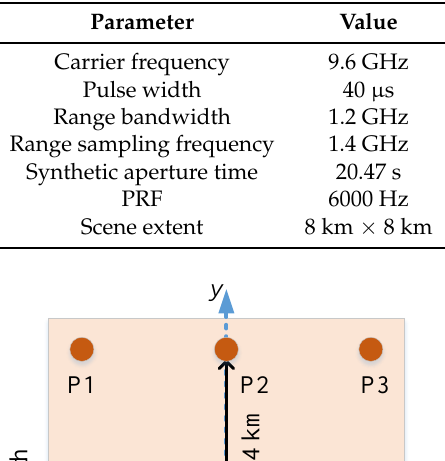
Table 3. Parameters of SAR System in Simulation Experiment